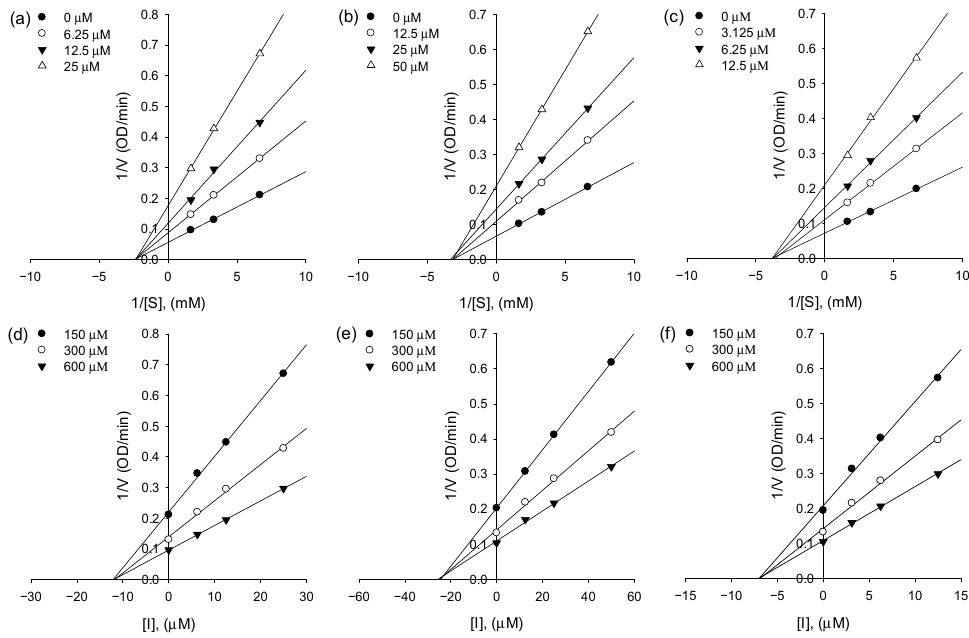
Figure 3. Kinetics and binding affinities of isolated iridal-type triterpenoids on HNE. ( a – c ) Lineweaver–Burk plots for the effect of 1 , 2 , and 3 on the HNE. ( d – f ) Dixon plots for the effect of 1 , 2 , and 3 on the HNE.